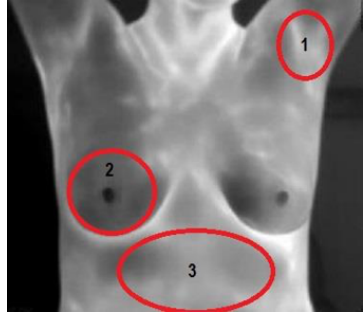
Figure 3. Selected areas to establish the thermal stability.